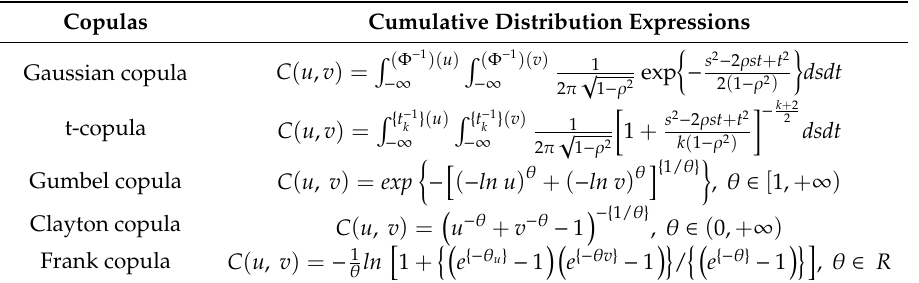
Table 1. Cumulative distributions of copulas.